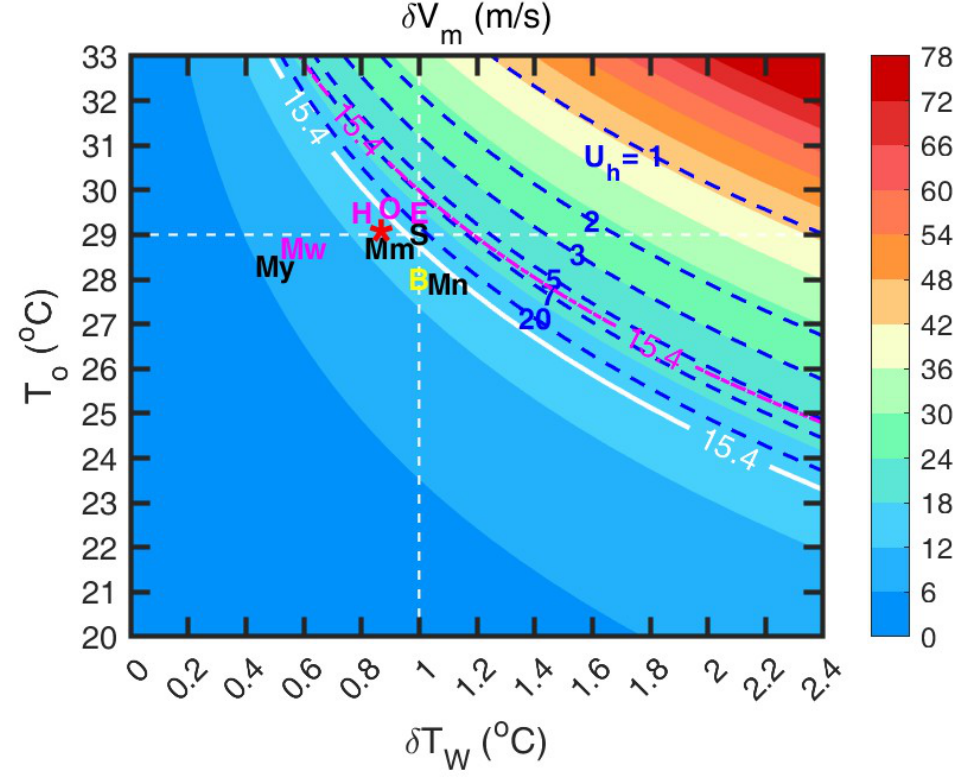
Figure 5. Color shading: western North Pacific’s δV m for U h = ∞ (i.e., no ocean feedback) as TC encounters a WOF with δT W warmer than the ambient T o ; white line is δV m = 15.4 m/s. Blue dashed lines are 15.4 m/s with ocean feedback for various U h . White dashed lines mark T o = 29 °C and δT W = 1 °C. Letters are observed RI TCs: Bansi (2015; pre‐RI intensity (pRIi) Cat.2) [28], Earl (2010; pRIi Cat.1) [27], Harvey (2017; pRIi TS) [29], Maemi (2003; pRIi Cat.1) and Maon (2004; pRIi Cat.1) [24], Manyi (2013; pRIi TS) [12], Matthew (2016; pRIi Cat.1) [56], Opal (1995; pRIi Cat.1) [22], and Soudelor (2015; pRIi TS) [16]. The red asterisk is their mean. The U h ranges from 3 (Mn) to 8.5 m/s (O). The magenta line is δV m = 15.4 m/s for the N Atlantic (no ocean feedback). The model uses γ = 0.02, h 1 = h 2 = 100 m and V O = 30 m/s.